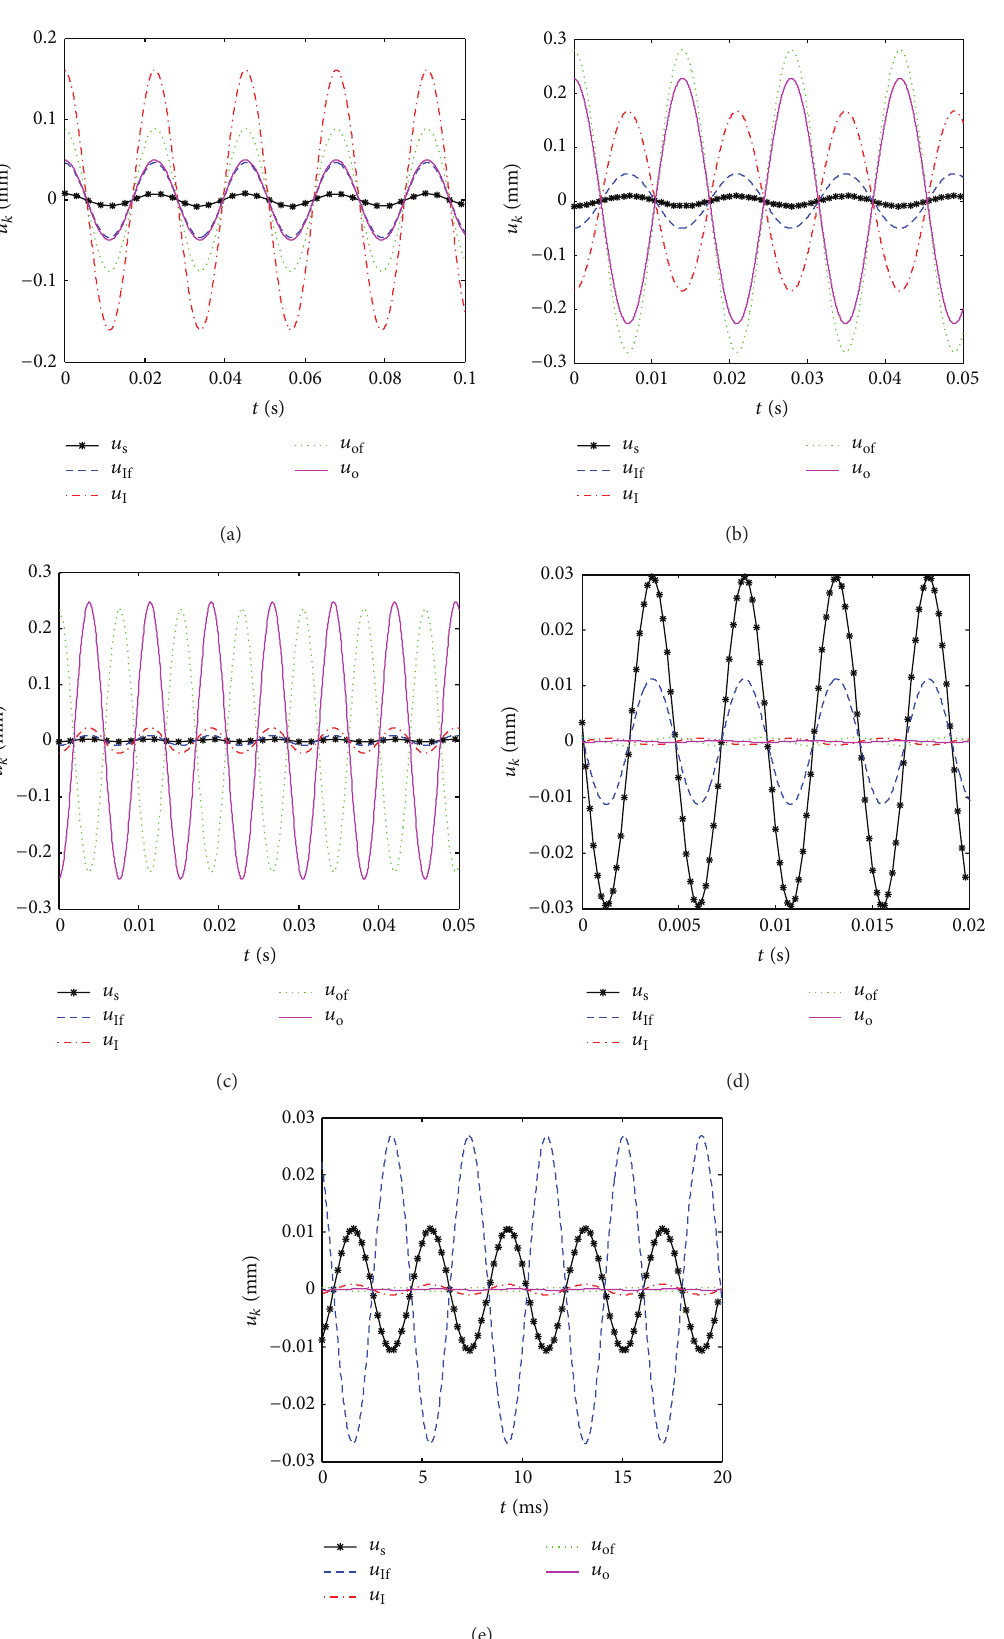
Figure 5: Main resonance of the EIMG